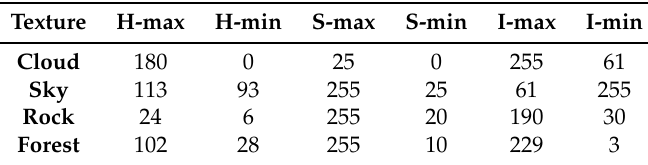
Table 1. HSI ranges of the base texture dictionary.